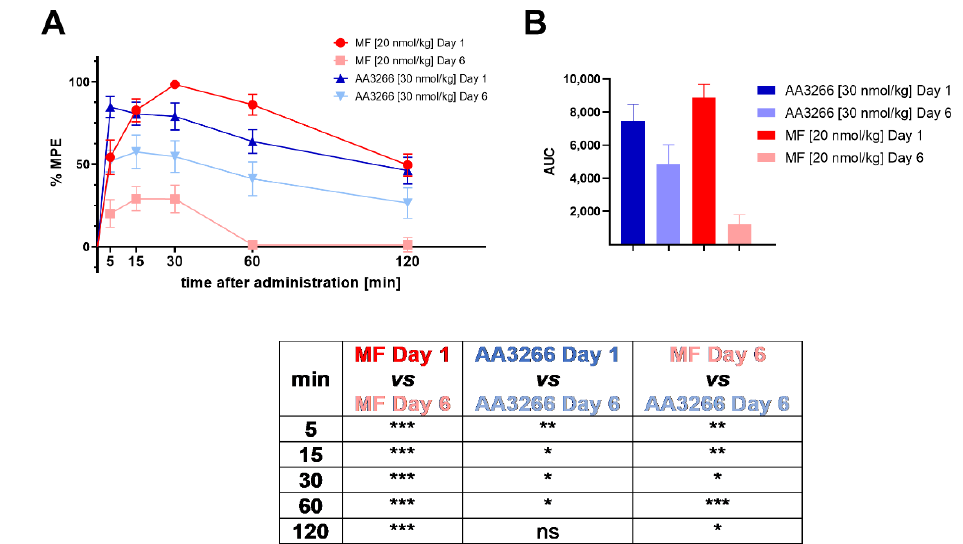
Figure 3. ( A ) Time and dose-dependence of antinociceptive e ff ect (i.t. administration, tail-flick test) of AA3266 (30 nmol / kg) compared to morphine (20 nmol / kg) on Day 1 and on Day 6 after prolonged administration. The results for the negative control (NaCl) were no di ff erent than zero in all the time points and so they are omitted from the plot for clarity. Thin bars show standard error of the mean. The results of statistical testing are given in a tabular form below the plots. The asterisks denote statistical significance of the di ff erence between the compared values (* p ≤ 0.05, ** p ≤ 0.01, *** p ≤ 0.001, ns—notsignificant). The statisticalanalysis used isthe Fisher’sLeast Significant Di ff erence test (planned comparisons; not corrected for multiple comparisons) at significance level α = 0.05. ( B ) Area under the antinociceptive response curve (prolonged